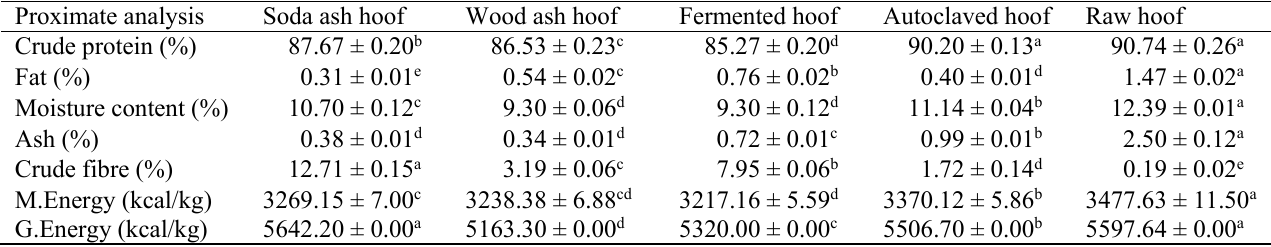
Proximate analysis of differently processed Cattle Hoof Proximate analysis Soda ash hoof Wood ash